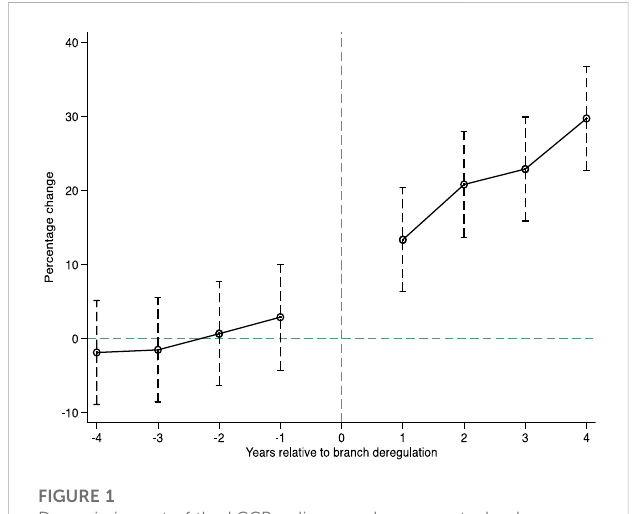
FIGURE 1 Dynamic impact of the LCCP policy on urban green technology innovation. Notes: The fi gure plots the impact of the LCCP on urban green technology innovation. The dependent variable is the natural log of the green patents granted in cities ( G_innov ), with an 8-year window spanning from 4 years before theLCCP policy until 4 years after the LCCP policy. All observations are at the city-year level. The dashed lines represent 95% con fi dence intervals adjusted for city-level clustering.